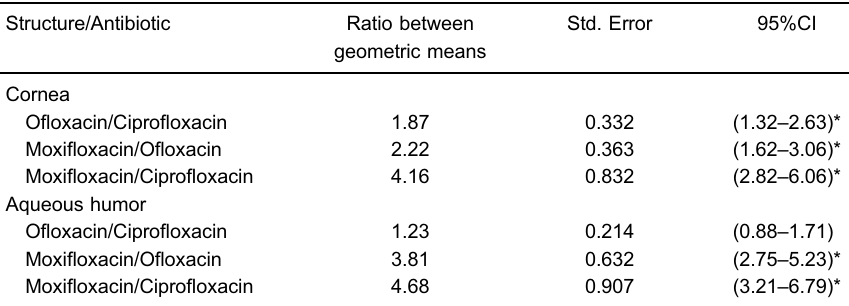
Table 3. Ratios between the geometric mean concentrations of pairs of antibiotics.